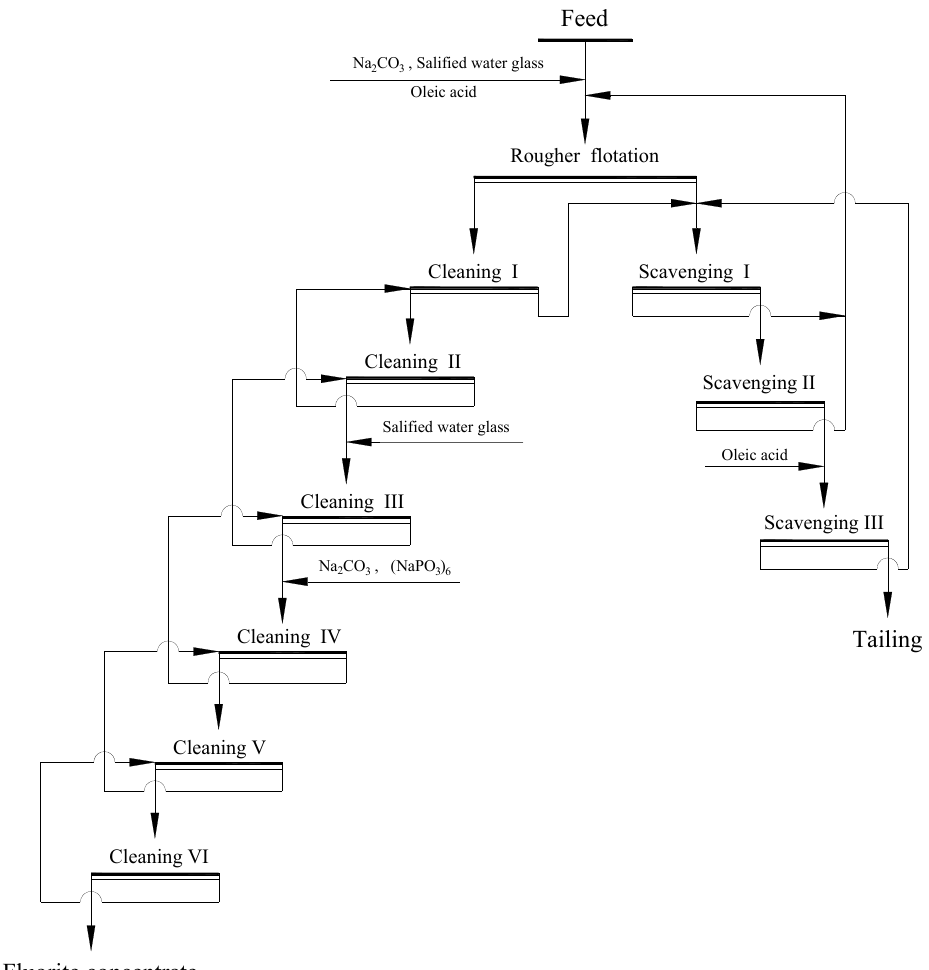
Figure 12. The beneficiation plant flotation flowsheet [110].